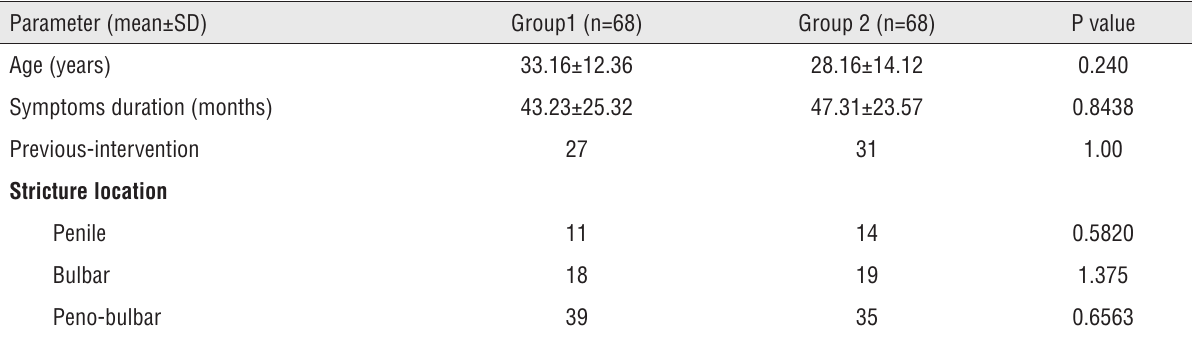
Table 1 - Basic demographic